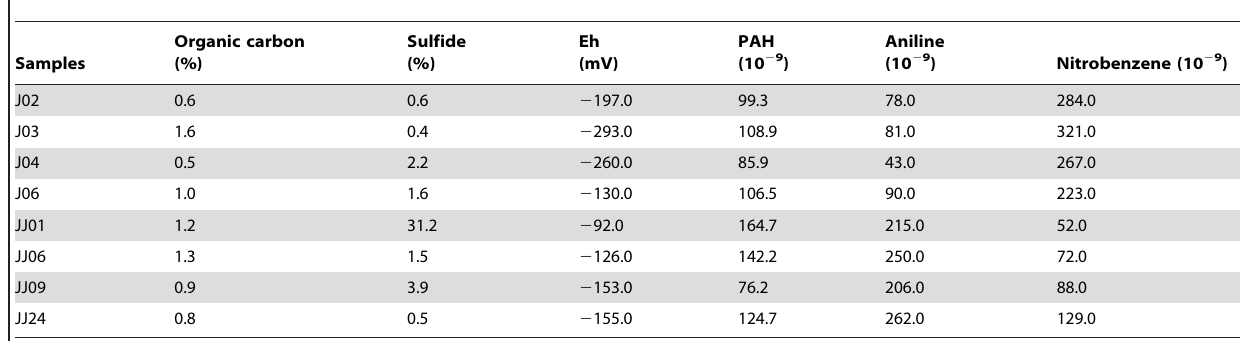
Table 2. The basic physical and chemical parameters of the Jiaojiang estuarine sediments.